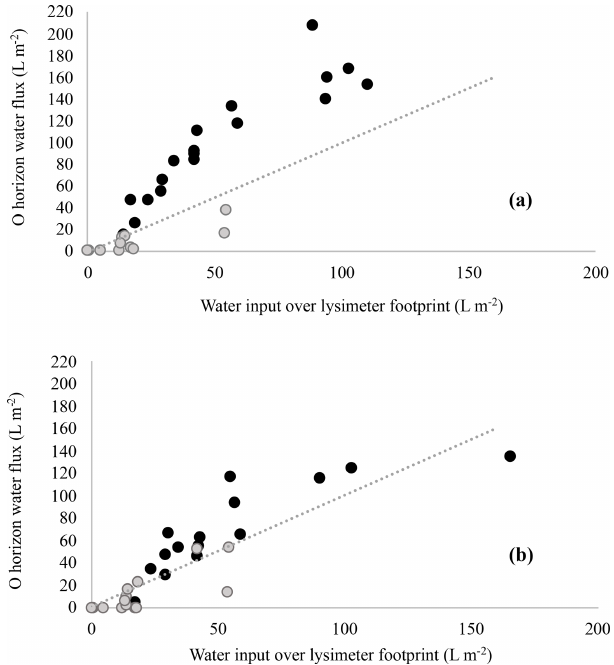
Figure 5. Lysimeter-captured water fluxes versus water input over the lysimeter footprint in harvested (a) and forest (b) plots. Lysime- ter collections made during periods when volumetric soil water con- tent remained below soil matrix saturation (grey circles) contrast with lysimeter collections made during periods when soil matrix saturation was reached (black circles). Matrix saturation in har- vested and forest plots was determined by infiltration experiments and complemented by soil evaporation measurements (see Table